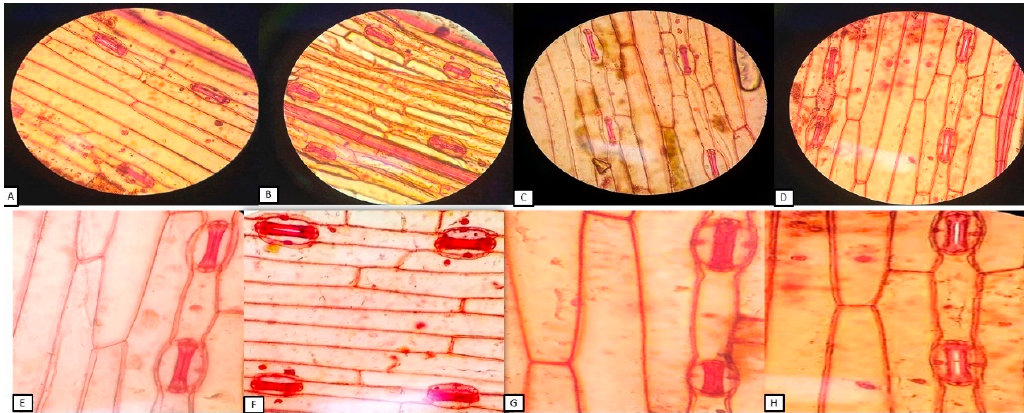
Figure 7. Stomatal area (SA) ( A – D ) and stomatal shape coe ffi cient (SSC) ( E – H ) at 40 × magnification in wheat at 30 DAS. Plants were grown individually with 0 (control), 100 mM NaCl, 300 ppm AgNPs and NaCl combined with AgNPs. ( A , E ) = control; ( B , F ) = AgNPs; ( C , G ) = salt stress; ( D , H ) = AgNPs + salt stress.